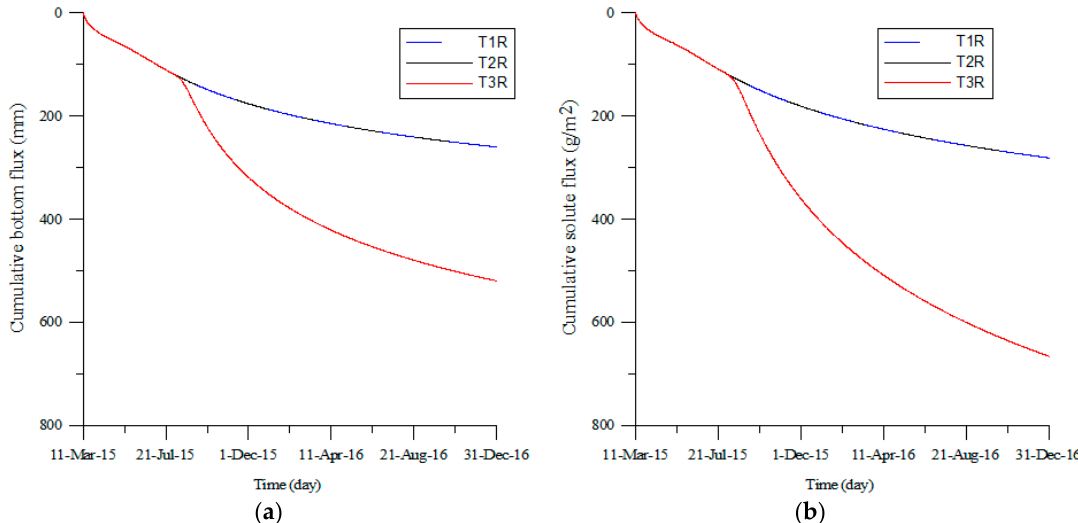
Figure 4. Cumulative ( a ) water and ( b ) solute bottom fluxes for different treatments calculated from 11 March 2015 to 31 December 2016. March 2015 to 31 December